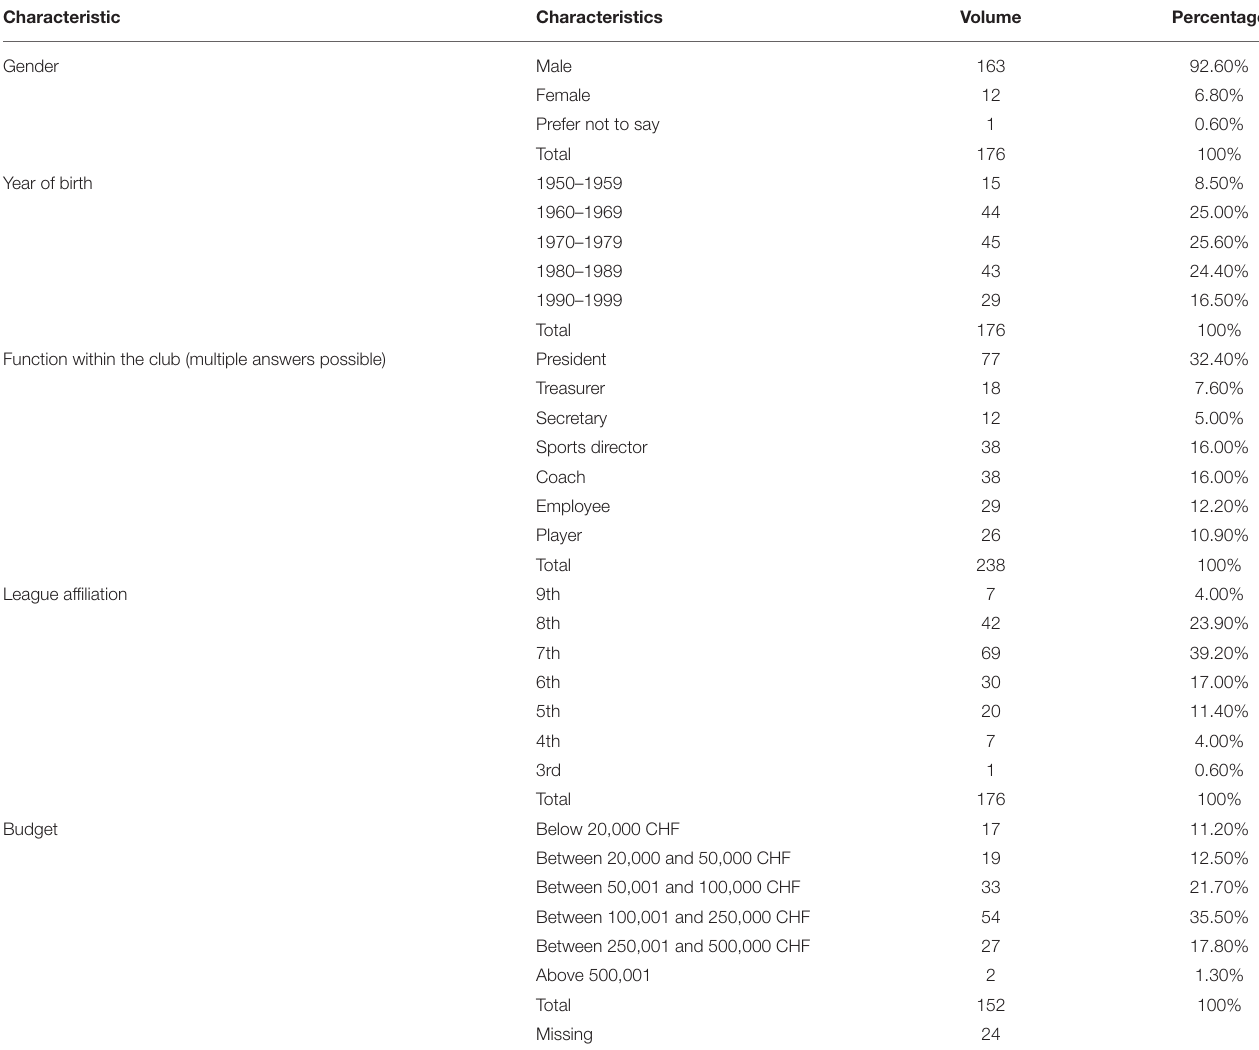
TABLE 2 | Demographic sample